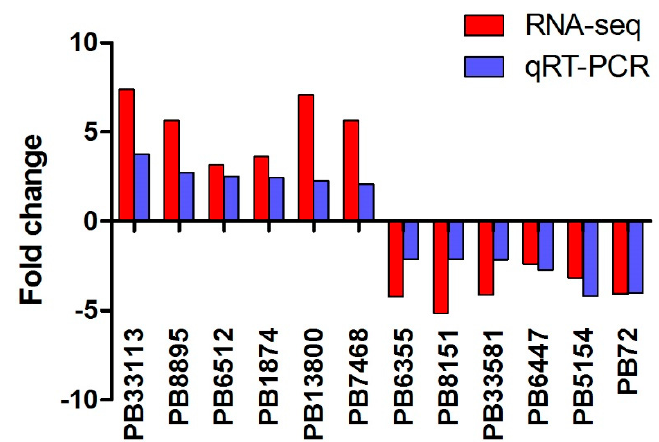
Figure 6. Validation of RNA-seq by quantitative reverse-transcription PCR. Twelve transcripts with different expression levels were identified using qRT-PCR. The y-axis indicates the relative expression levels (Fold change) based on DET analysis and qRT-PCR. Three independent replications were set.